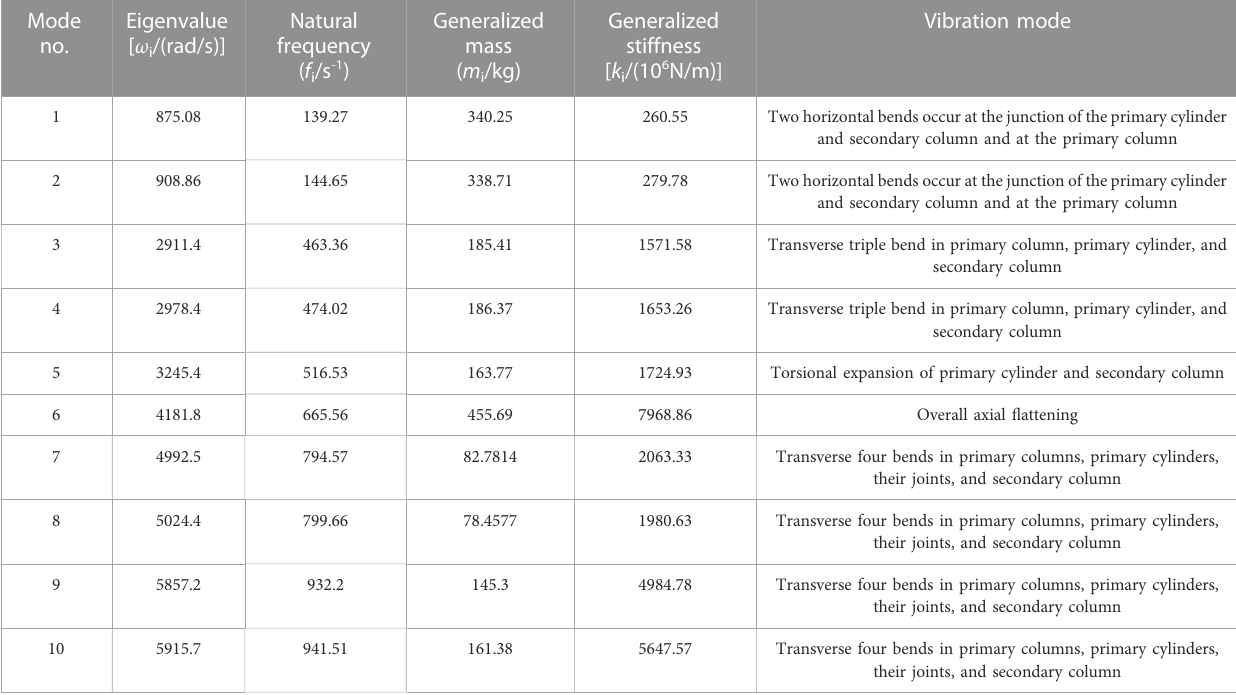
TABLE 7 Frequency and vibration mode for the fi rst 10 orders of the conventional column. Mode